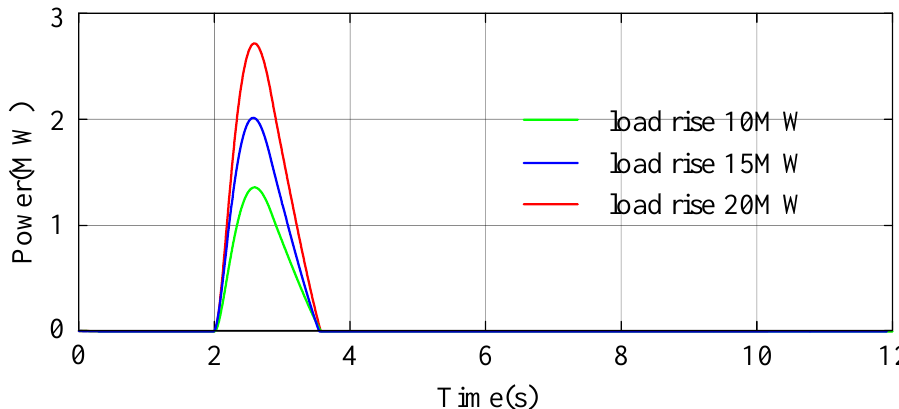
Figure 21. Operation curve of SCESS at medium wind speed.